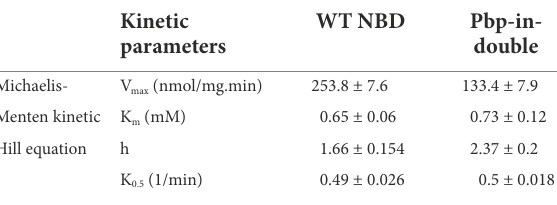
TABLE 3 Summary of the kinetic parameters of HlyB NBD wild type and the mutated variants. Kinetic parameters